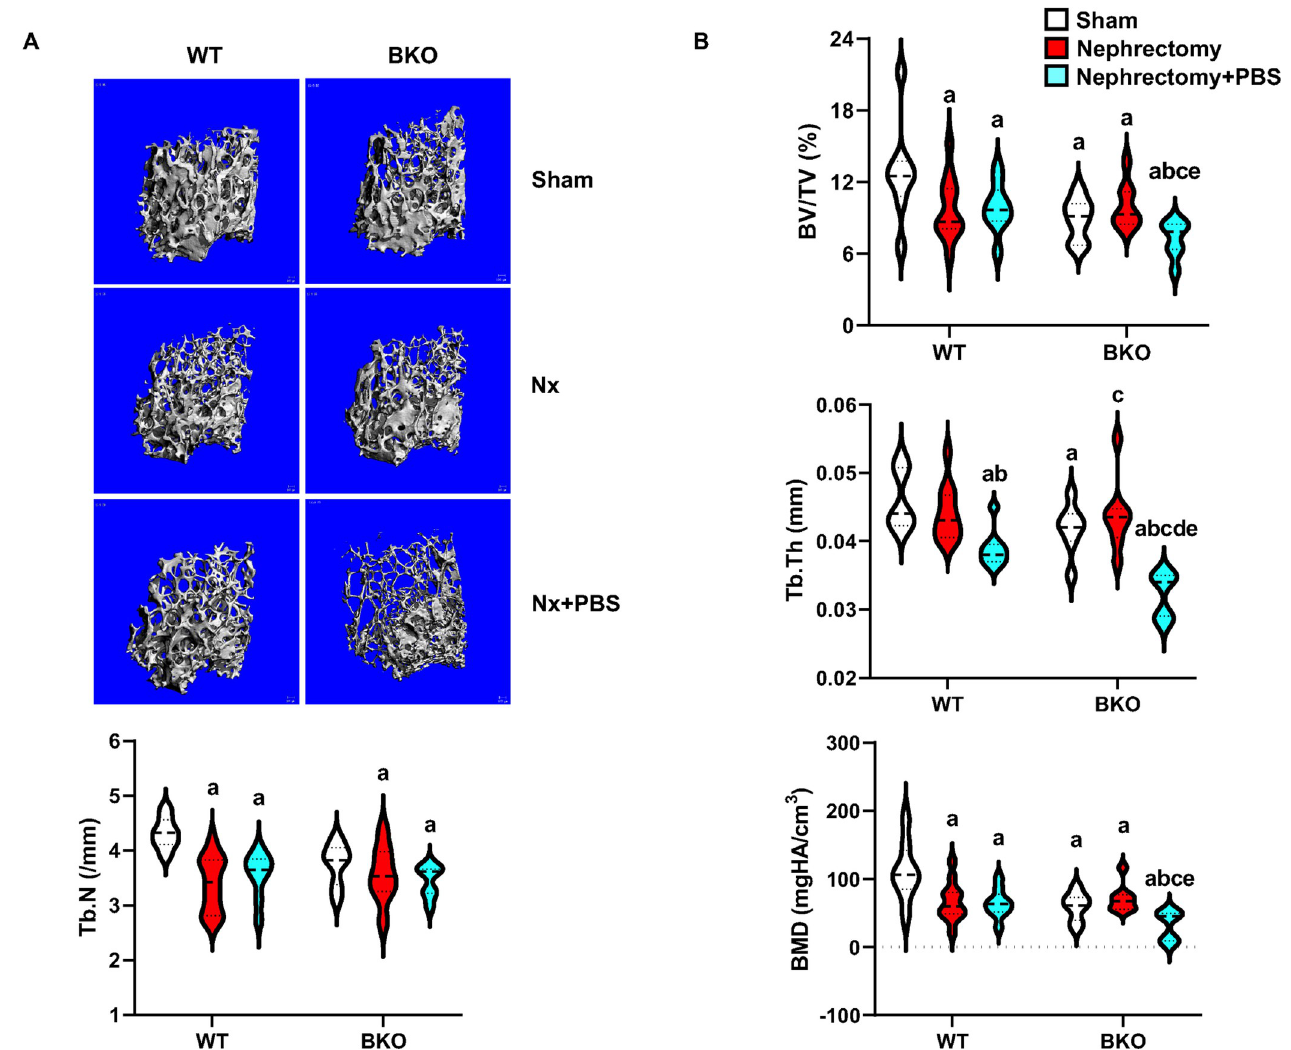
Fig 3. High phosphate induces cancellous bone loss in nephrectomized BKO mice. (A) Representative μ CT images of cancellous bone. (B) μ CT analysis of cancellous bone as violin plots. a p < 0.05 versus sham WT, b p < 0.05 versus nephrectomized WT, c p < 0.05 versus nephrectomized WT+PBS, d p < 0.05 versus sham BKO, and e p < 0.05 versus nephrectomized BKO.